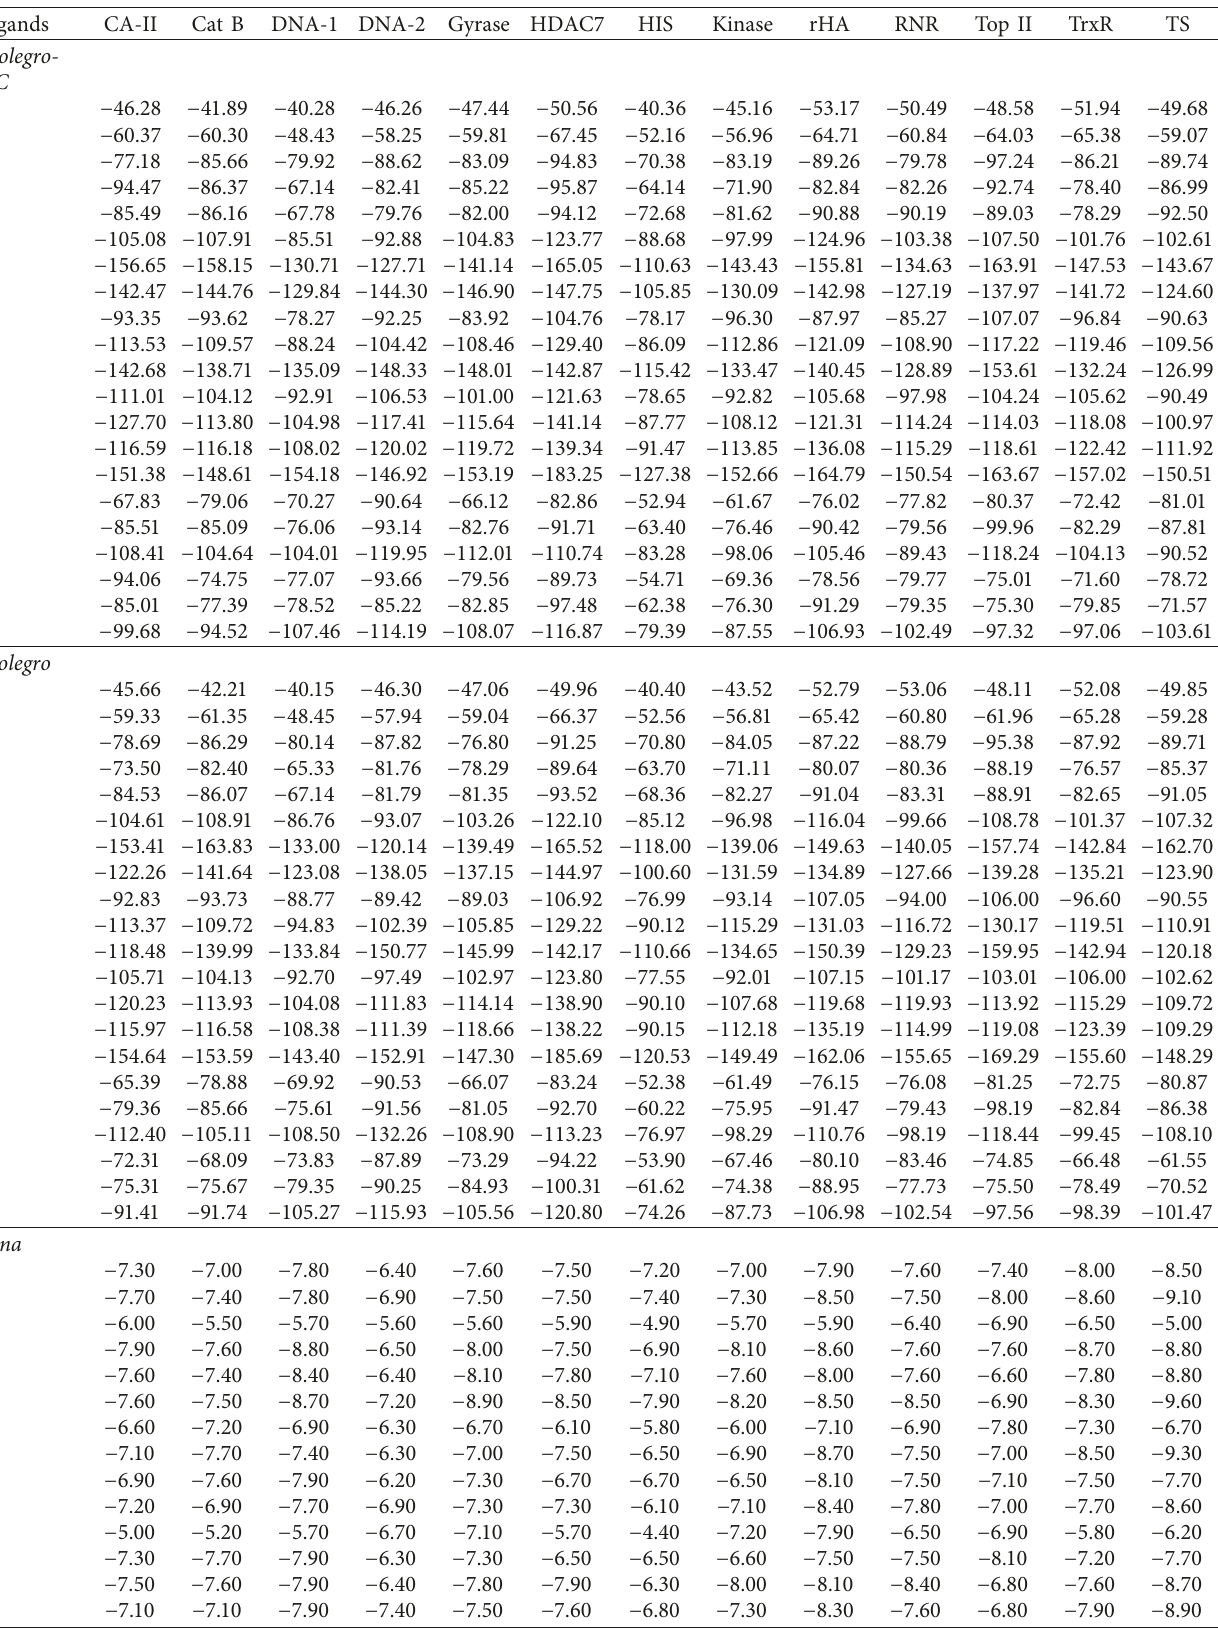
Table 2: The interacting free energy of the ligands with the receptors using the five docking methods approached. Ligands CA-II Cat B